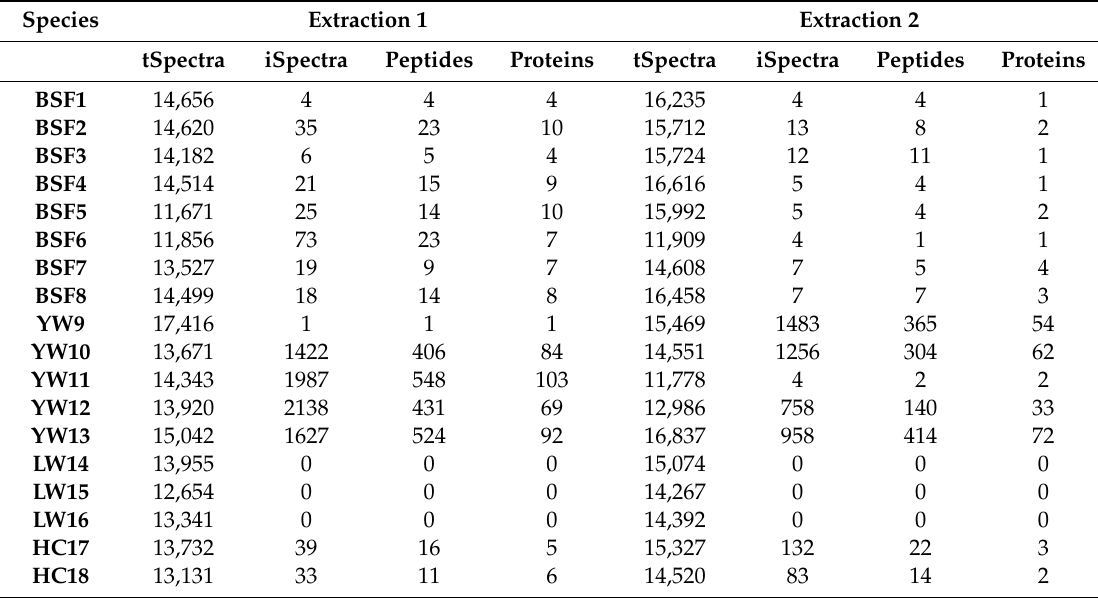
Table 5. Total numbers of spectra and successfully identified insect specific proteins and peptides in 18 insect meal samples, performed independently at two di ff erent laboratories (A and